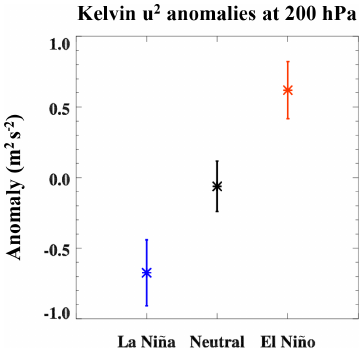
Figure 15. The squared perturbations in zonal mean zonal wind for Kelvin waves averaged over 10 ◦ S–10 ◦ N at 200hPa for La Niña (blue star), neutral (black star), and El Niño (red star) conditions. The error bars denote ± 1 standard deviation of the mean